Question: What does this figure show? Answer in one sentence.
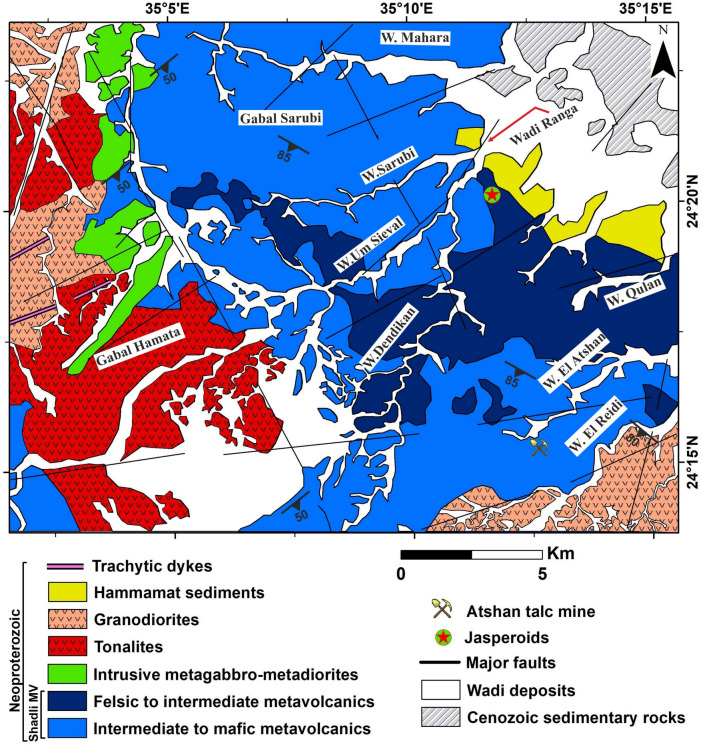
Answer: A detailed geologic map of the WRAM area based on remote sensing data and field verification shows the different rock units, structures, jasperoids, and Wadis in the study area. This figure was created by ArcGIS Desktop 10.8 ( https://www.esri.com/en-us/arcgis/products/arcgis-online ).